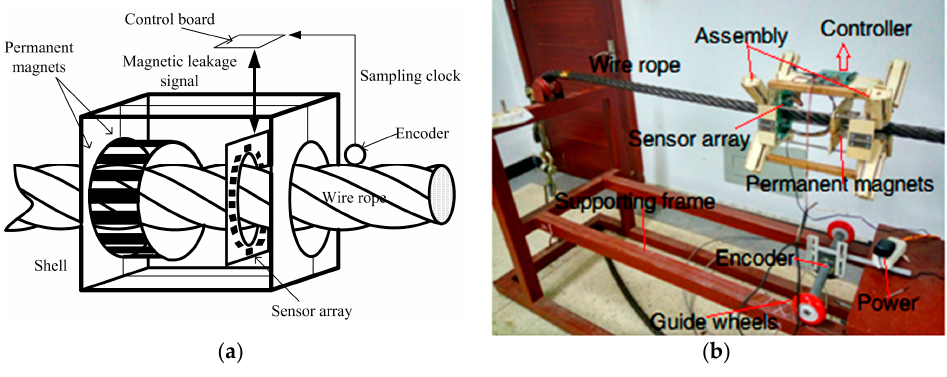
Figure 3. ( a ) The structure of the prototype; ( b ) the object of experimental application.